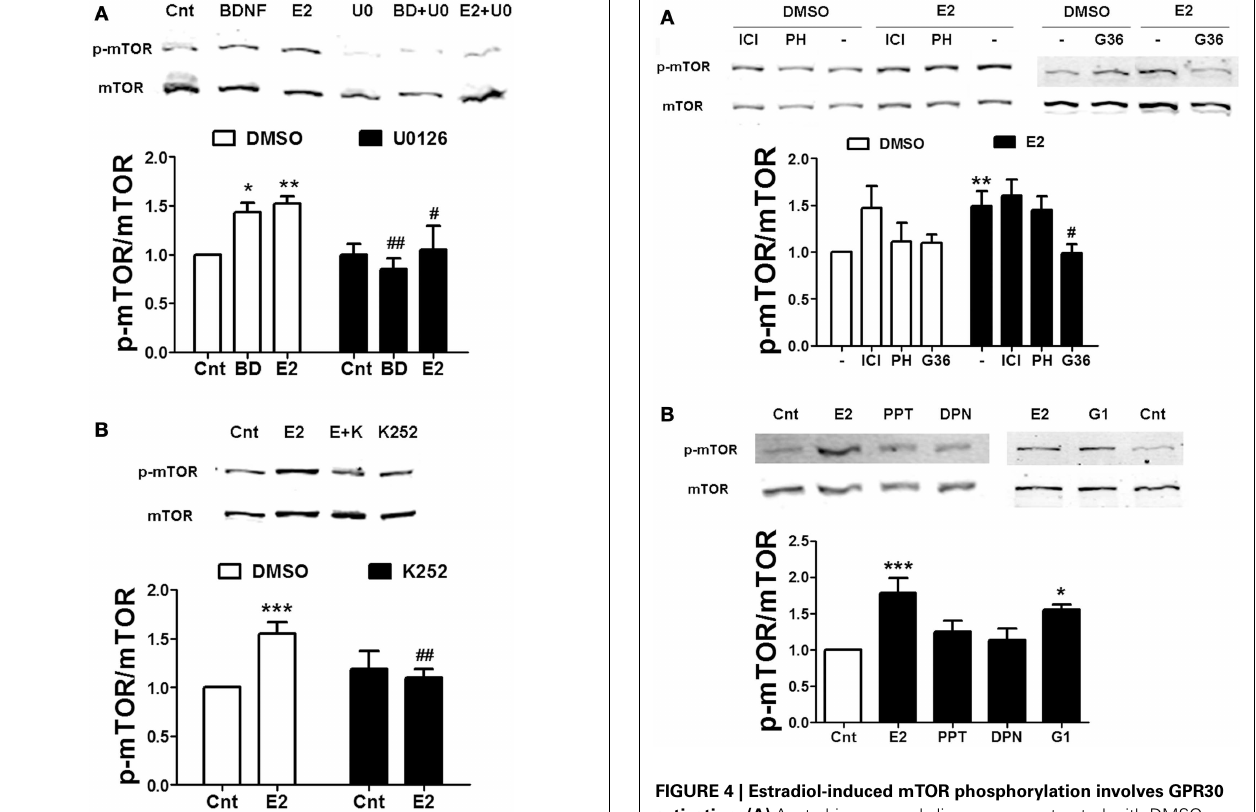
FIGURE 4 | Estradiol-induced mTOR phosphorylation involves GPR30 activation . (A) Acute hippocampal slices were pre-treated with DMSO (Cnt), ICI 182780 (ICI, 1 µ M), PHTPP (PH, 1 µ M), or G36 (1 µ M) for 30min and then incubated with estradiol (E2, 10nM) for additional 30min. At the end of treatments, slices were homogenized and processed for western blot. Data are presented as the ratio (fold of control) of p-mTOR over total mTOR ( N = 4–10). (B) Acute hippocampal slices were treated with estradiol (E2, 10nM), PPT (100nM), DPN (10nM), or G1 (100nM) and homogenized and processed for western blot. Data are presented as the ratio (fold of control) of p-mTOR over total mTOR ( N = 4–6); * p < 0.05, *** p < 0.001, as compared to control (DMSO) (one- or two-way